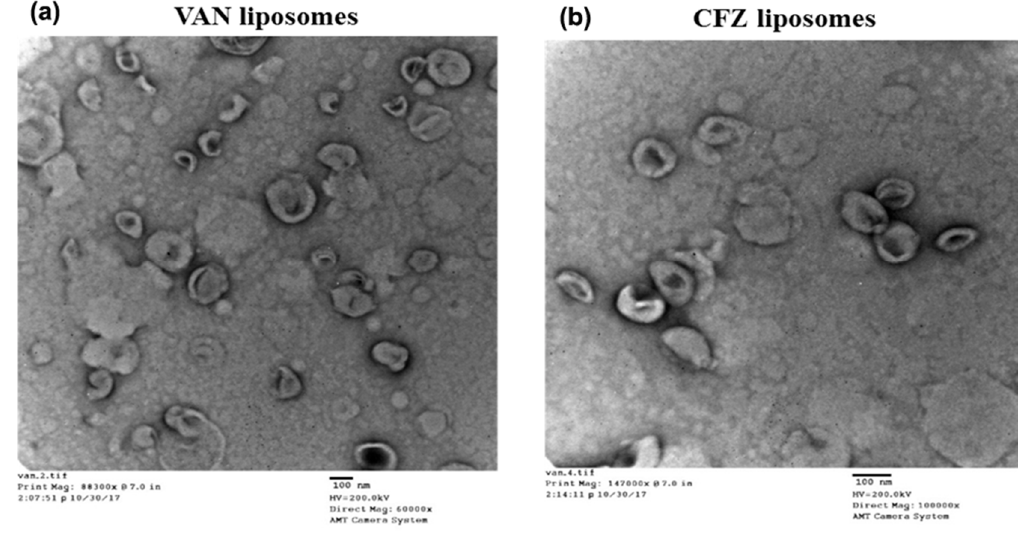
Figure 2. Transmission electron microscopy (TEM) of ( a ) VAN liposomes and ( b ) CFZ liposomes that clearly shows the lipid bilayer formation.